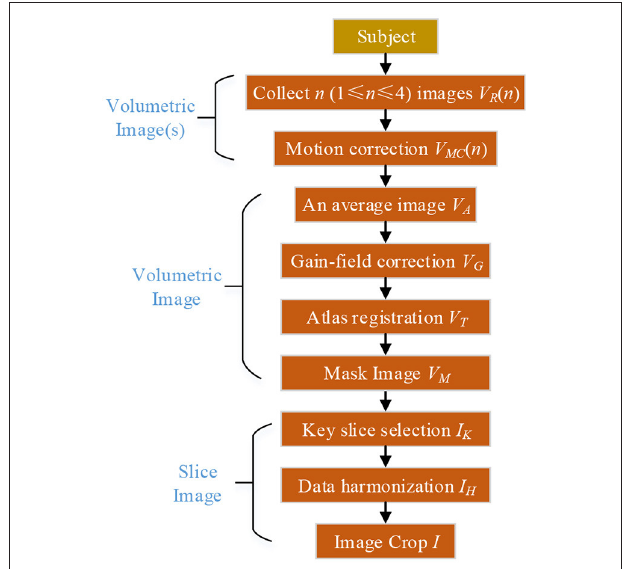
FIGURE 2 | Pipeline of